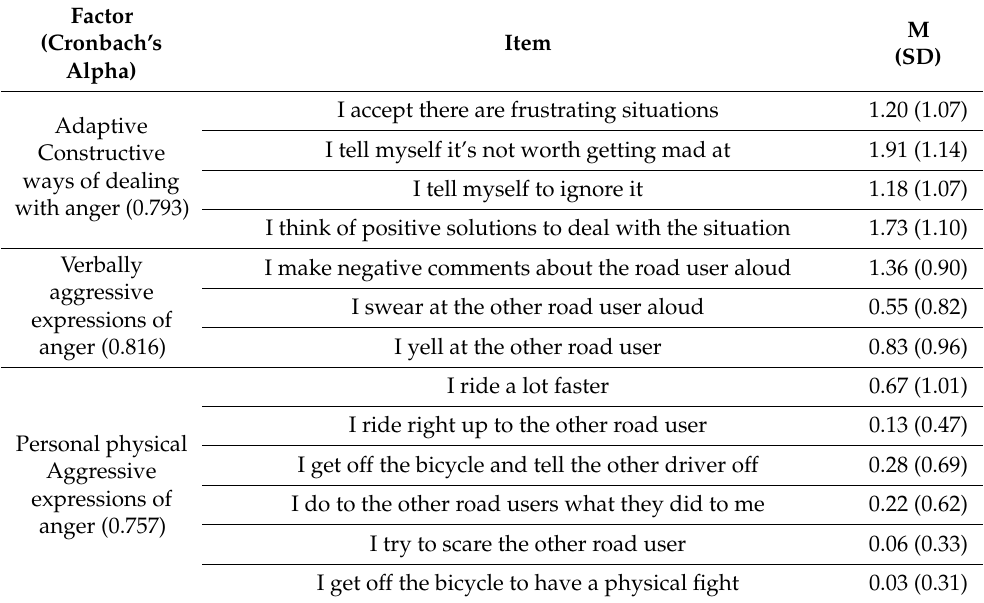
Table 4. Cyclist Aggression Expression